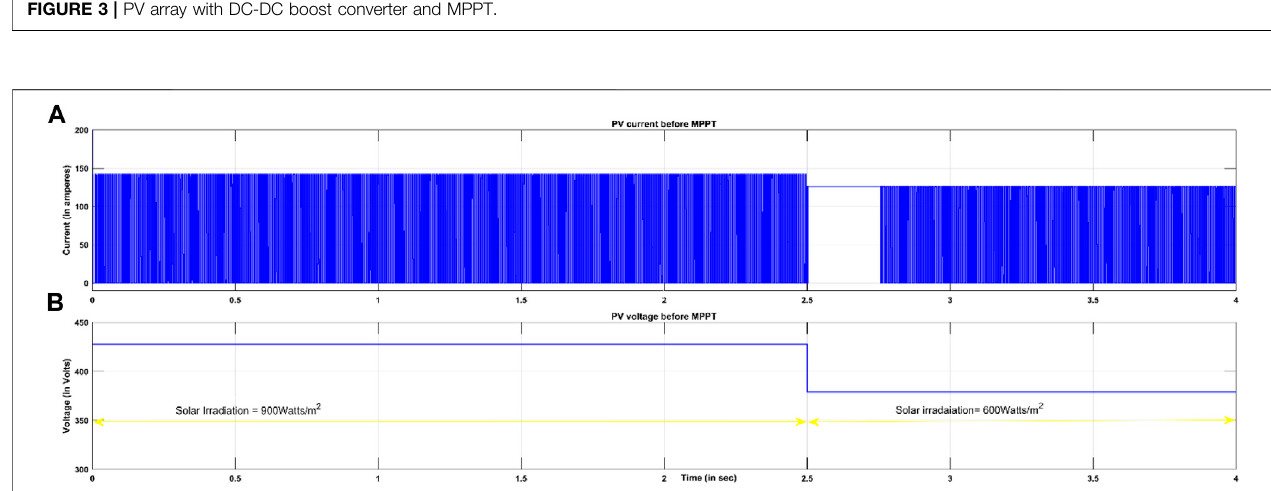
FIGURE 3 | PV array with DC-DC boost converter and MPPT.